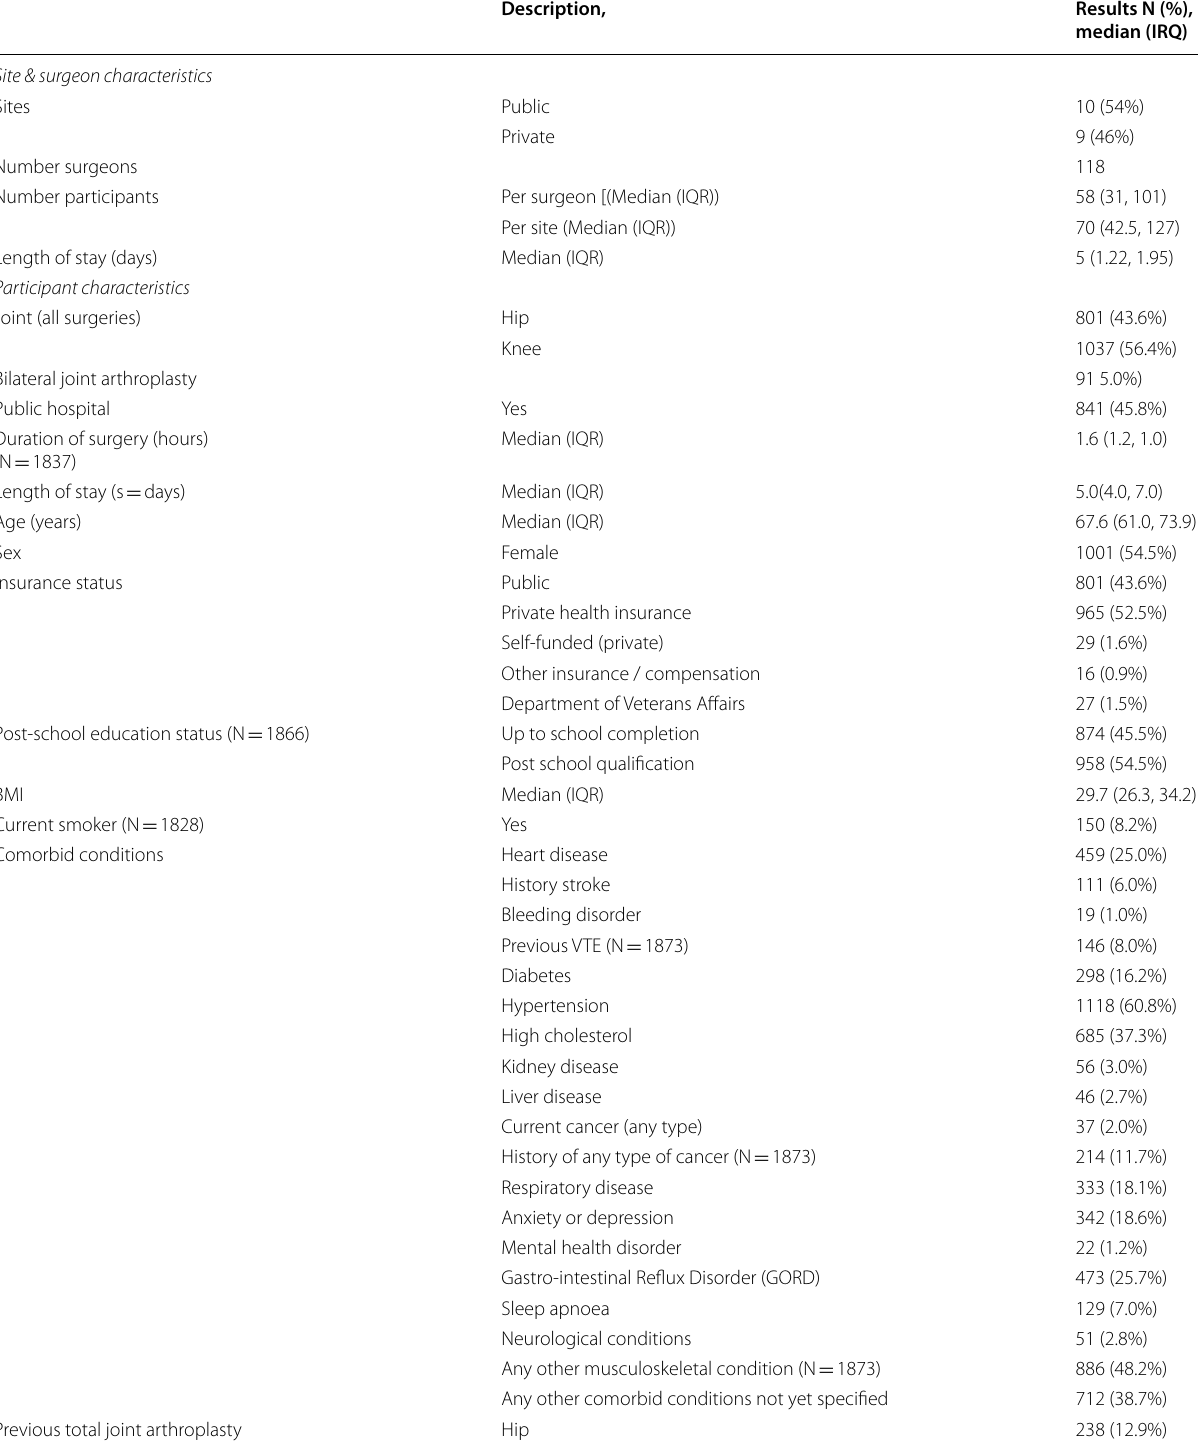
Table 1 Site, surgeon, participant and care characteristics